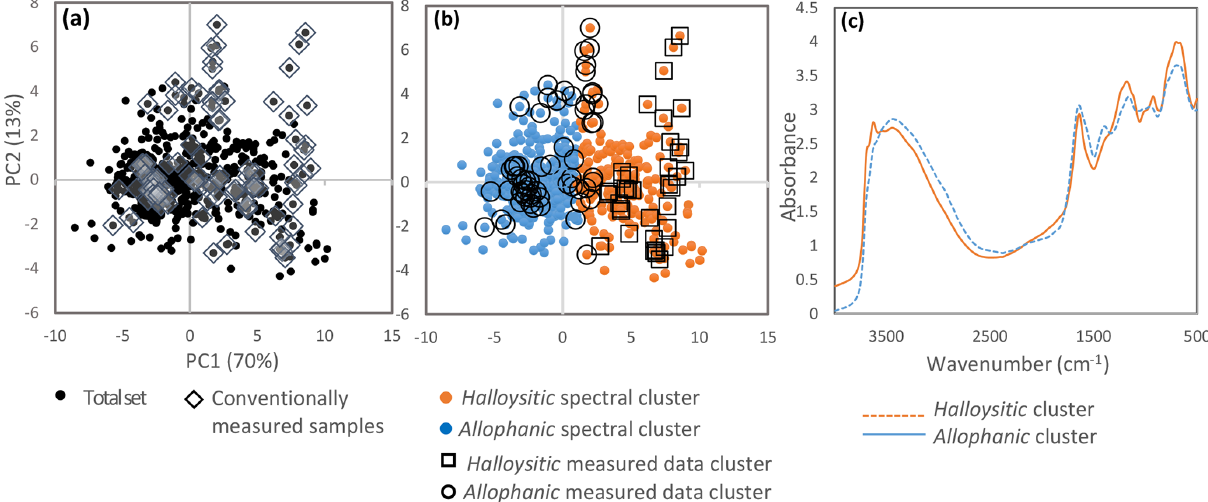
Figure 2. Mid-infrared (MIR) spectra analyses for the total set of soil samples ( n = 598) and for the samples ( n = 98) that were chemically analysed conventionally to determine contents of Al o , Al p , Fe o , and Si o . (a) Principal component analysis (PCA) of all spectra. Diamond shapes identify the 98 conventionally analysed samples. (b) PCA and identification of two clusters built either on the PCA of all the 598 MIR spectra (solid blue and red points) or on the PCA of the compositions of the 98 conventionally analysed samples (empty circles and squares). (c) Average MIR spectra of the soil samples from allophanic and halloysitic spectral